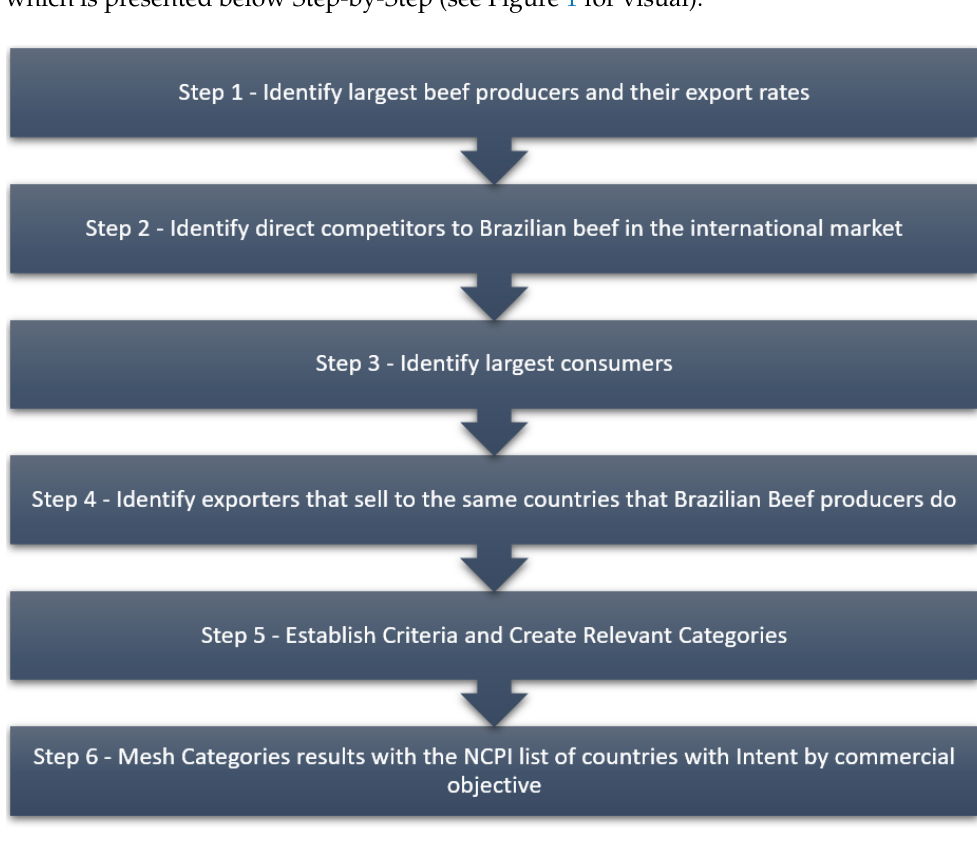
Figure 1. Methodology to find Brazilian beef contenders with cyber attack capacities and